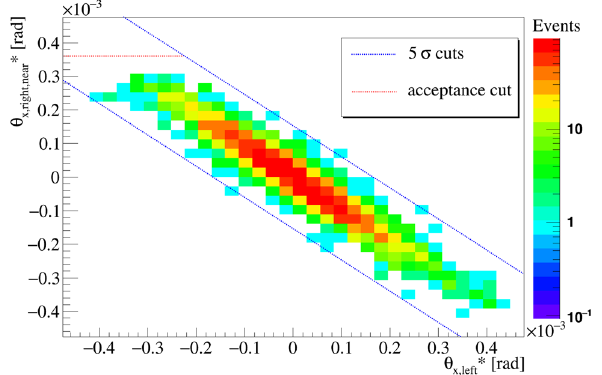
Fig. 3 The horizontal angular smearing, divergence, of the beam esti- mated from the data of Diagonal 1. The distribution is shown before any analysis cut (black solid line) and before and after the last cut, see Table 1. The residual background is estimated with a Gaussian fit of the tail before the last analysis cut